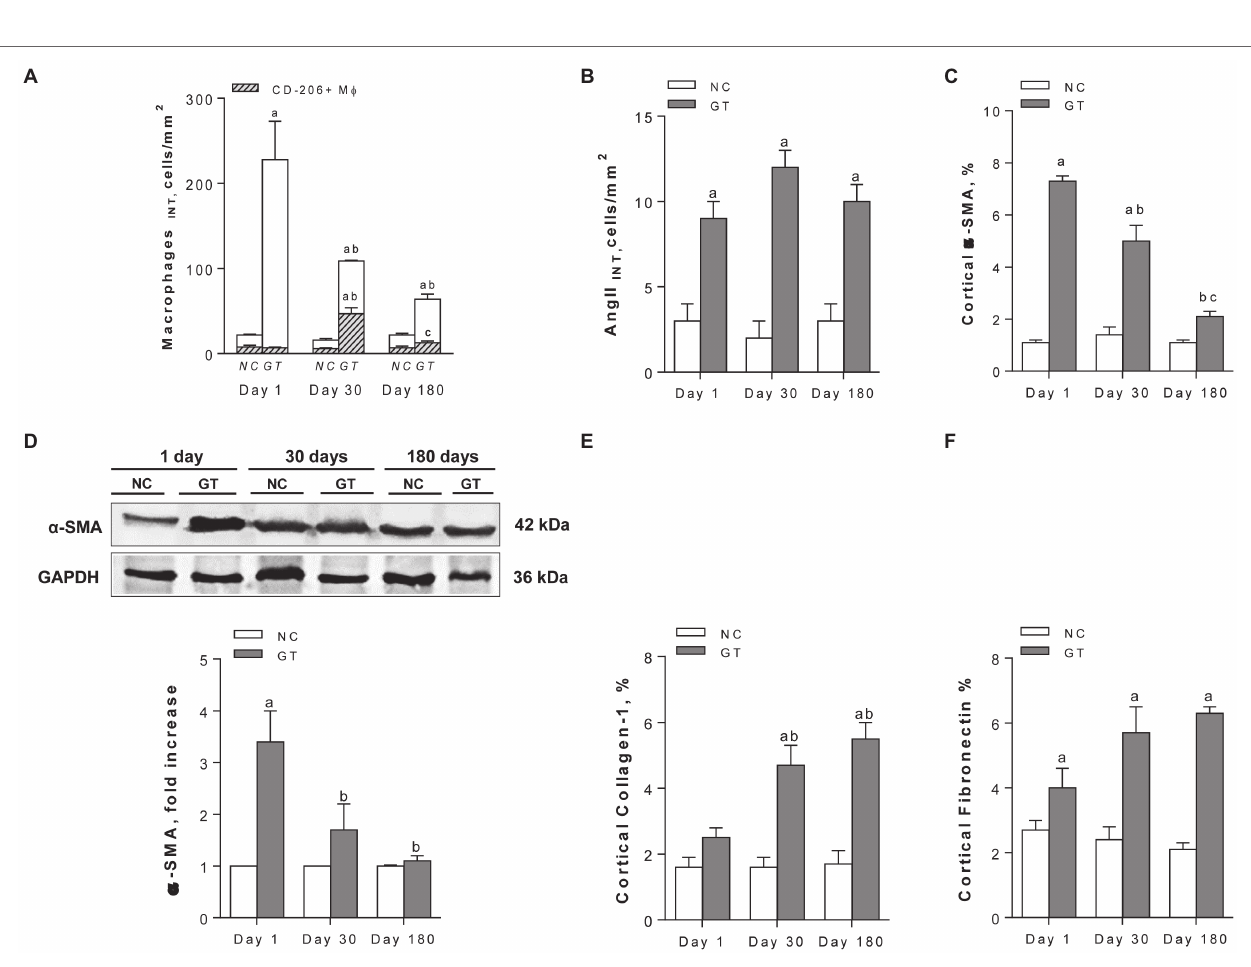
FIGURE 5 | Quantitative analysis. (A) interstitial macrophages, with the CD206-positive fraction represented by the hatched areas; (B) interstitial AngII-positive cells; (C) percent cortical α -SMA-positive area (by immunohistochemistry); (D) renal abundance of α -SMA (by Western blot); and (E,F) percent Collagen-1- and Fibronectin-positive cortical areas, respectively (by immunohistochemistry), in groups NC and GT on Days 1, 30, and 180. Western blot analysis included seven animals per group. Results expressed as means ± SE . a p < 0.05 vs. NC, b p < 0.05 vs. Day 1, and c p < 0.05 vs. Day